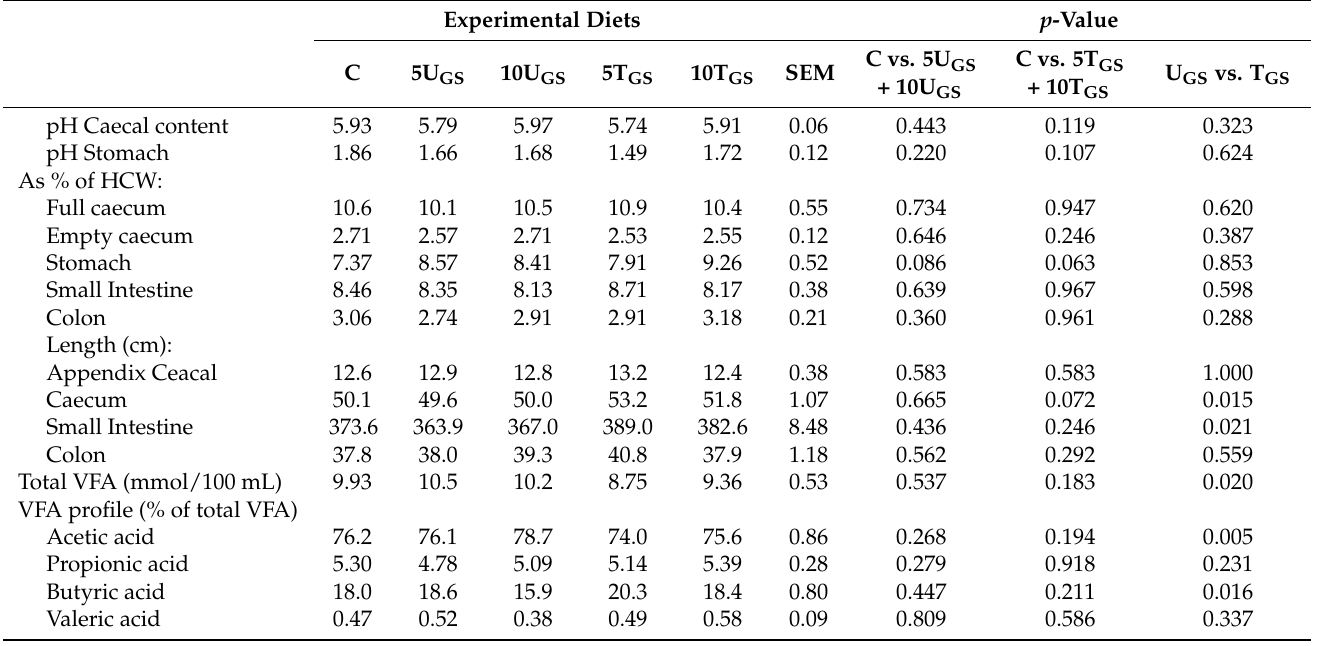
Table 4. Effect of the experimental diets on pH of caecal content and stomach, gastrointestinal tract physiology, and total concentration and profile of volatile fatty acids ( n = 10).